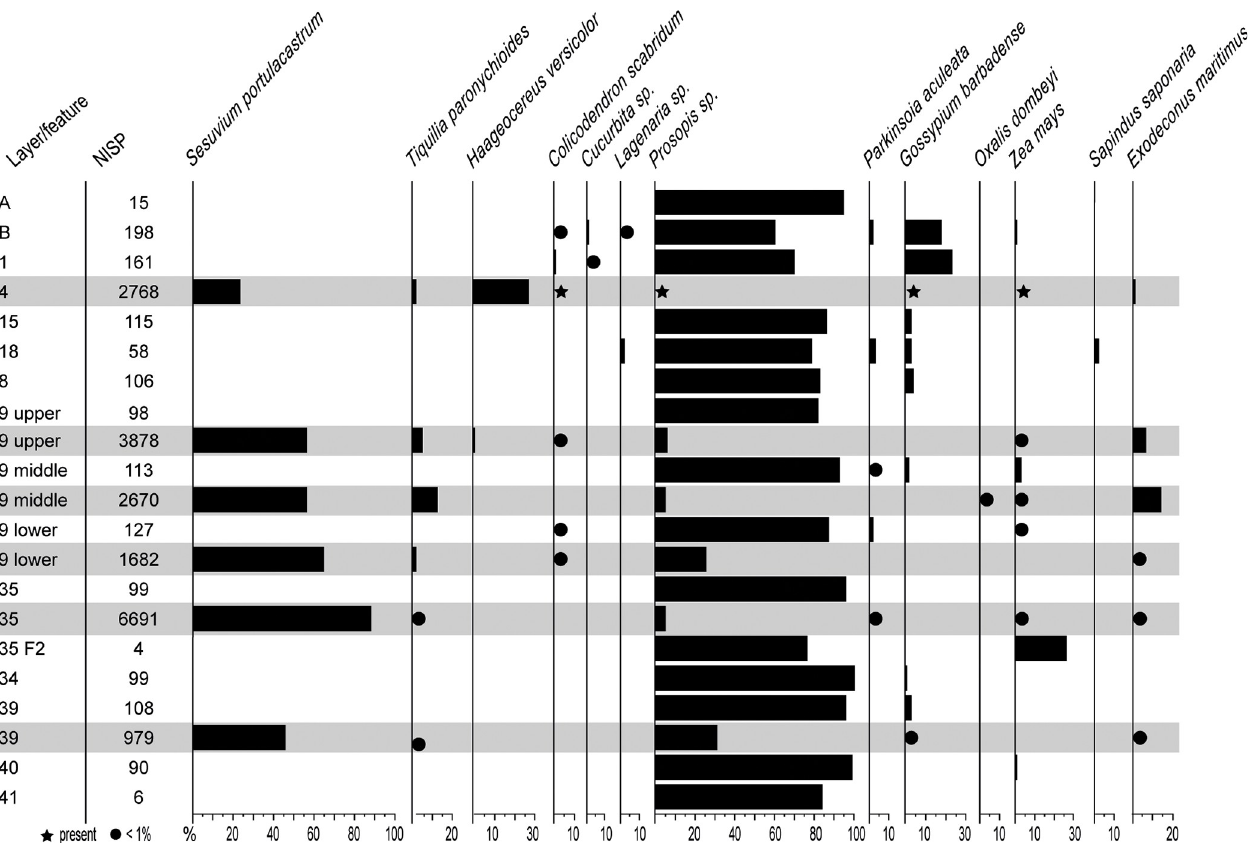
Fig 12. Huaca Grande carpological assemblage. NISP, ubiquity and/or proportions of the taxa identified in trench A4.1. Grey shading highlights flotation samples.